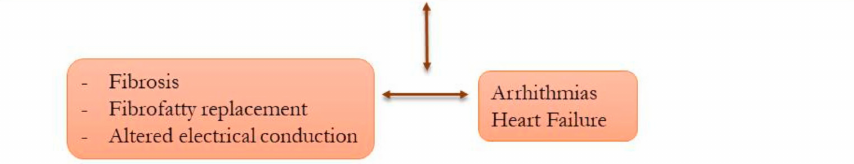
Figure 5. Immunity involvement in ACM. The comparison of many studies and case reports suggests that, regardless of the genesis, myocarditis seems to be at least a phase (if not the core) of ARVC pathophysiology, creating a vicious cycle which leads to arrhythmias and heart